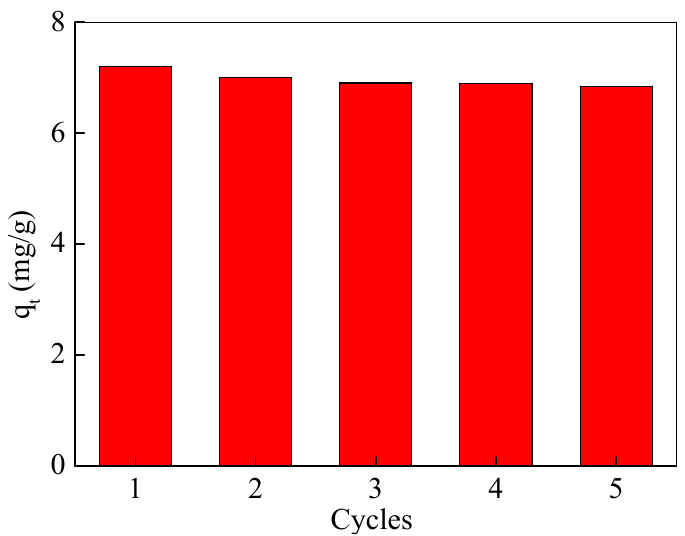
Figure 5. Regeneration capacity of Fe 3 O 4 @SiO 2 @N(CH 3 ) 3+ for acetic acid removing.